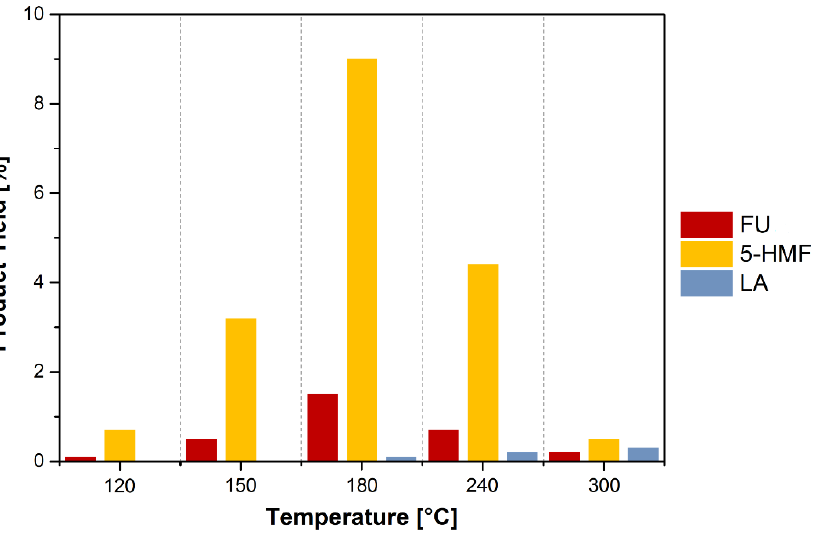
Figure 4. Effect of HTC reaction temperature on the production of furfural (FU), 5-hydroxymethylfurfural (5-HMF) and levulinic acid (LA) from OPW under neutral conditions (Reaction conditions: 20 g of OPW; 20 mL of H 2 O; time: 60 min; autogenous pressure; stirring: 600 rpm).